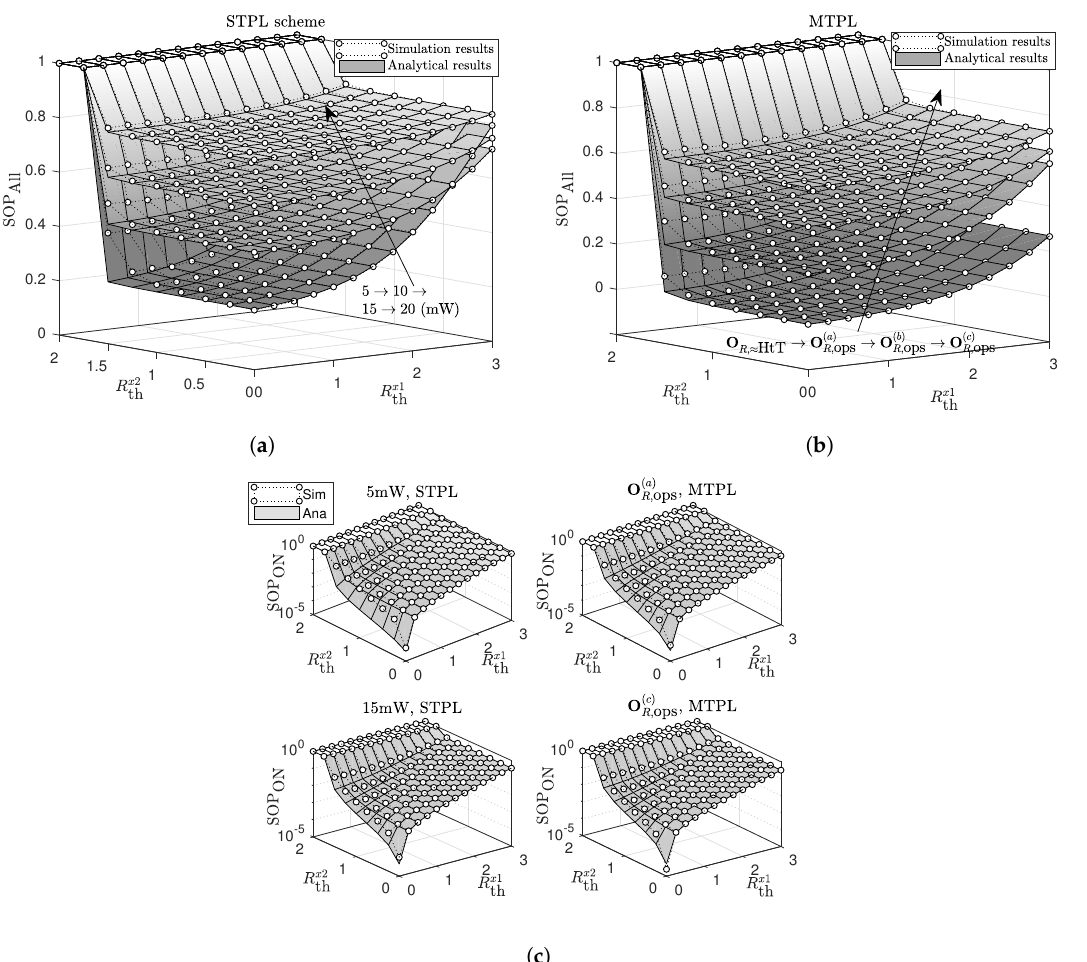
Figure 3. The effect of R x 1 and R x 2 on ( a ) SOP All for the STPL scheme, ( b ) SOP All for the MTPL scheme, th th and ( c ) SOP ON for both STPL and MTPL